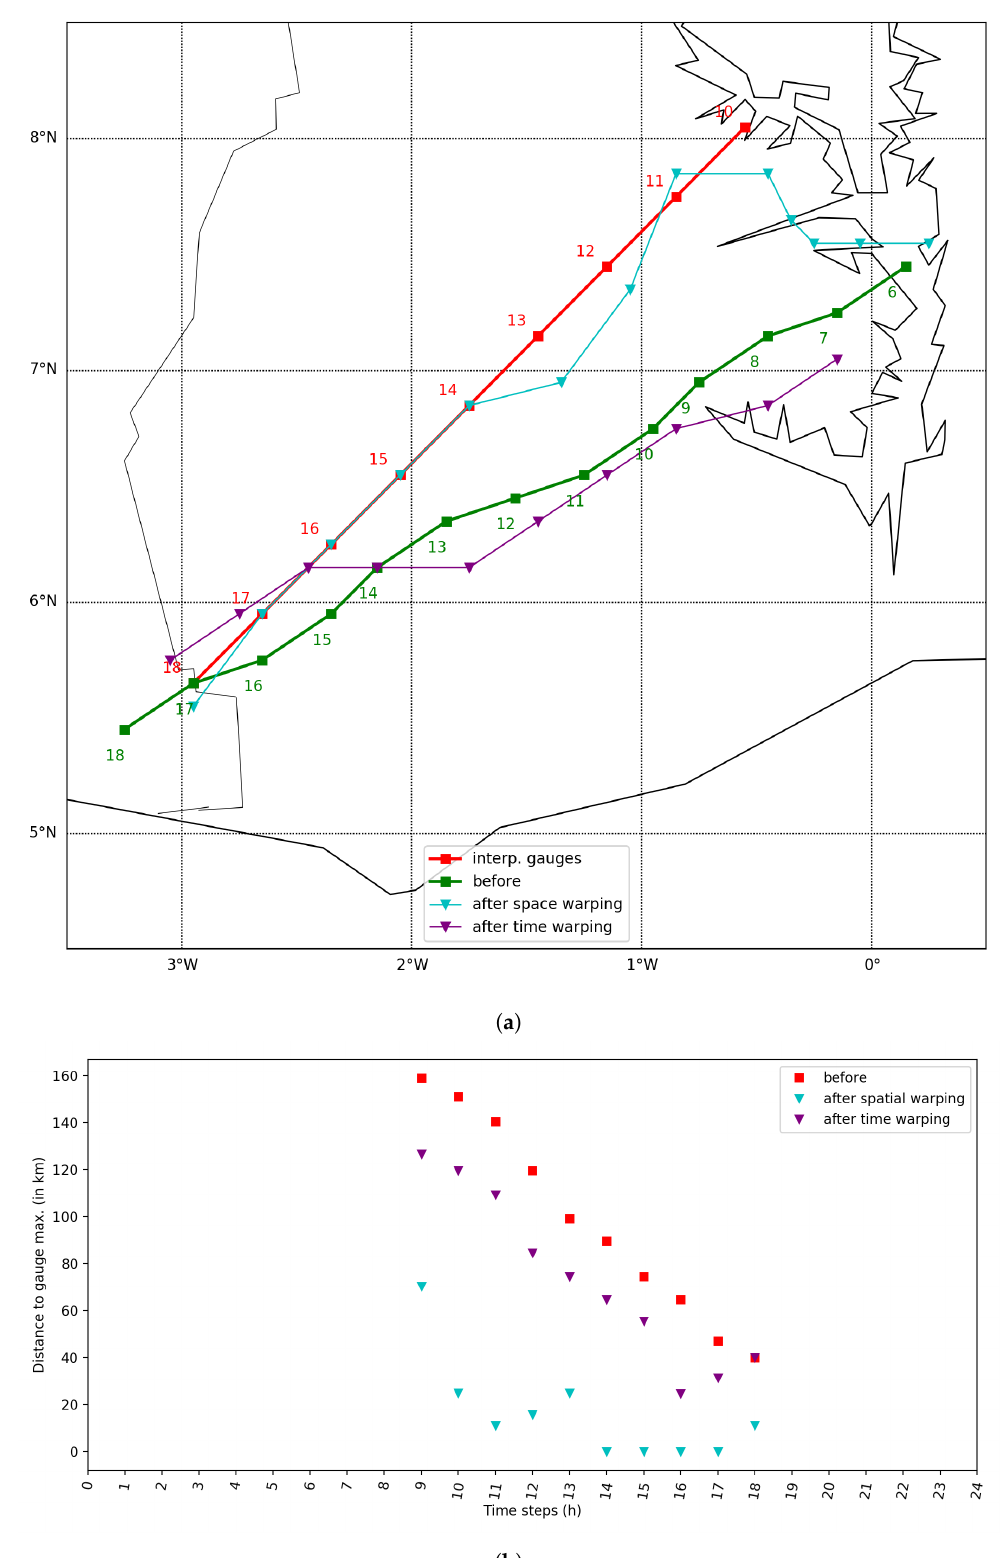
Figure 9. Position error of the peak before and after warping for time steps with more than 0.1 mm/h of rainfall (in both u and v ). The peak is defined as the pixel with the maximum rainfall at a given time step. ( a ) Path of the peak before and after warping. The numbers indicate the time steps represented by the points. ( b ) Distance between the “true” peak and the estimated one before and after warping as a function of